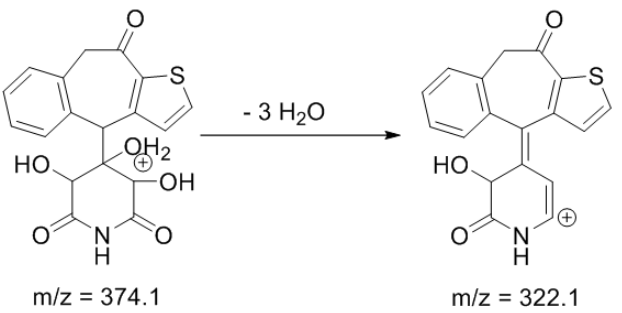
Figure 6. Fragmentation pattern of ketotifen (KETO) degradation product K-DP4.